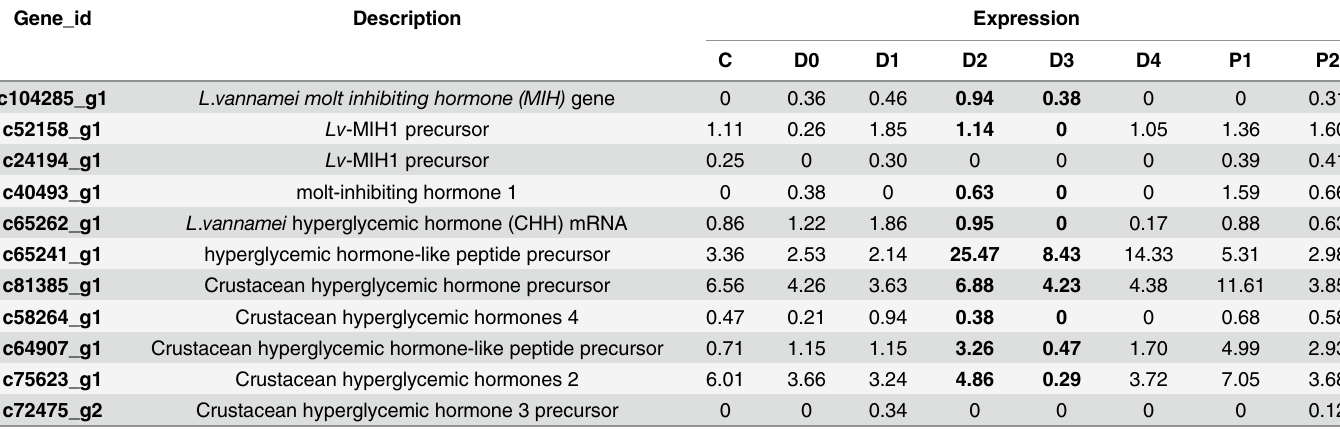
Expressions levels are represented by fragments per kilobase of exon per million fragments mapped (FPKM) at each stage. Bold text denotes down- regulation at D2 and D3. Changes in c65241_g1 expression between D2 and D3 meet the criterion of differentially expressed genes (log2ratio (cid:1) 1 and FDR (cid:3)